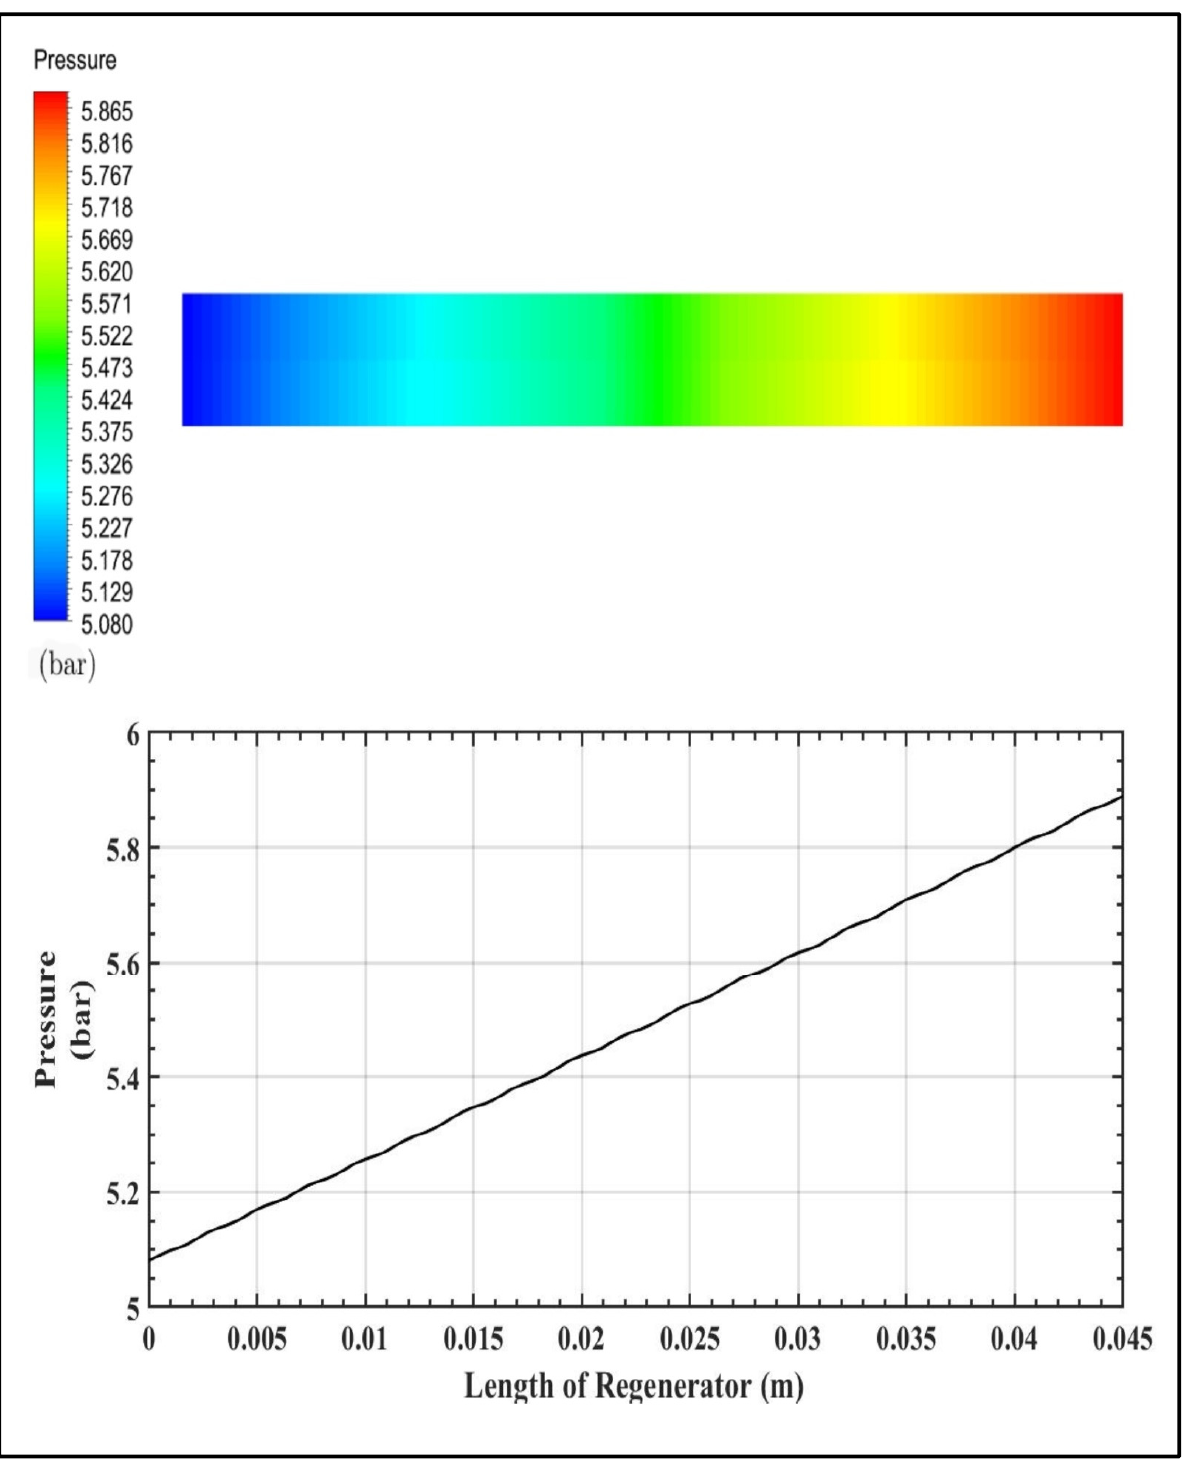
Figure 27. Variation of pressure along the length of the 300 mesh regenerator at 0.37 s.